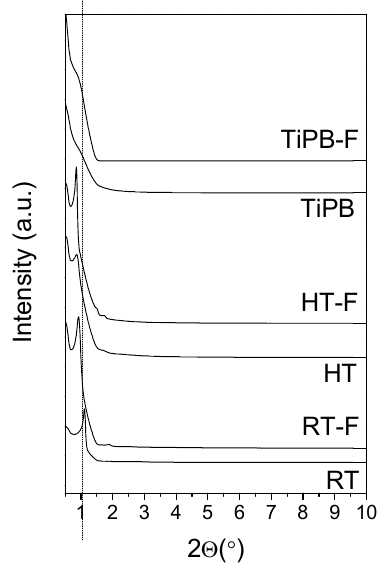
Figure 1. Low angle X-ray diffraction (XRD) patterns of pure